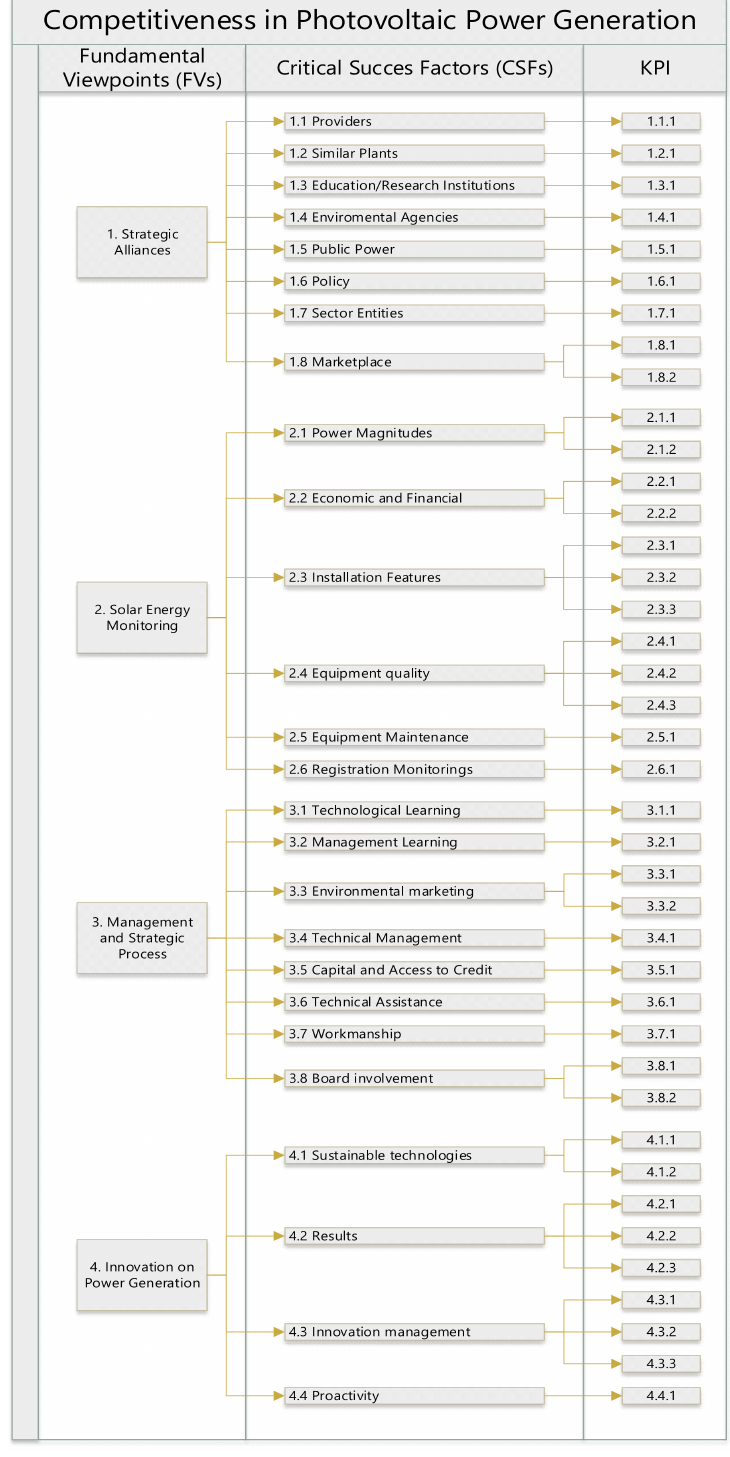
Figure 2. Hierarchical structure for the evaluation of competitiveness in Photovoltaic Power